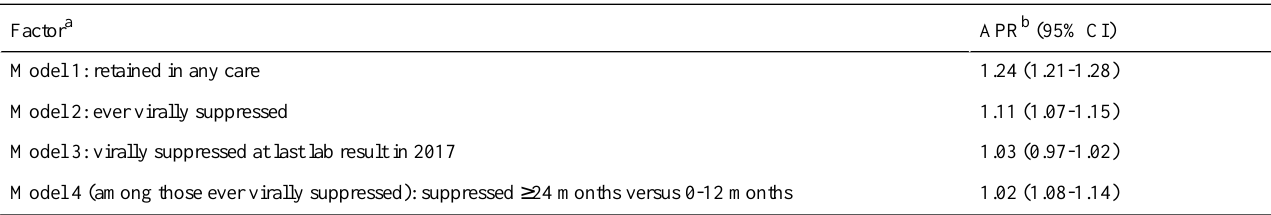
Table 4. Adjusted prevalence ratios for clinical characteristics of DC Cohort and non-DC cohort participants living in DC as of December